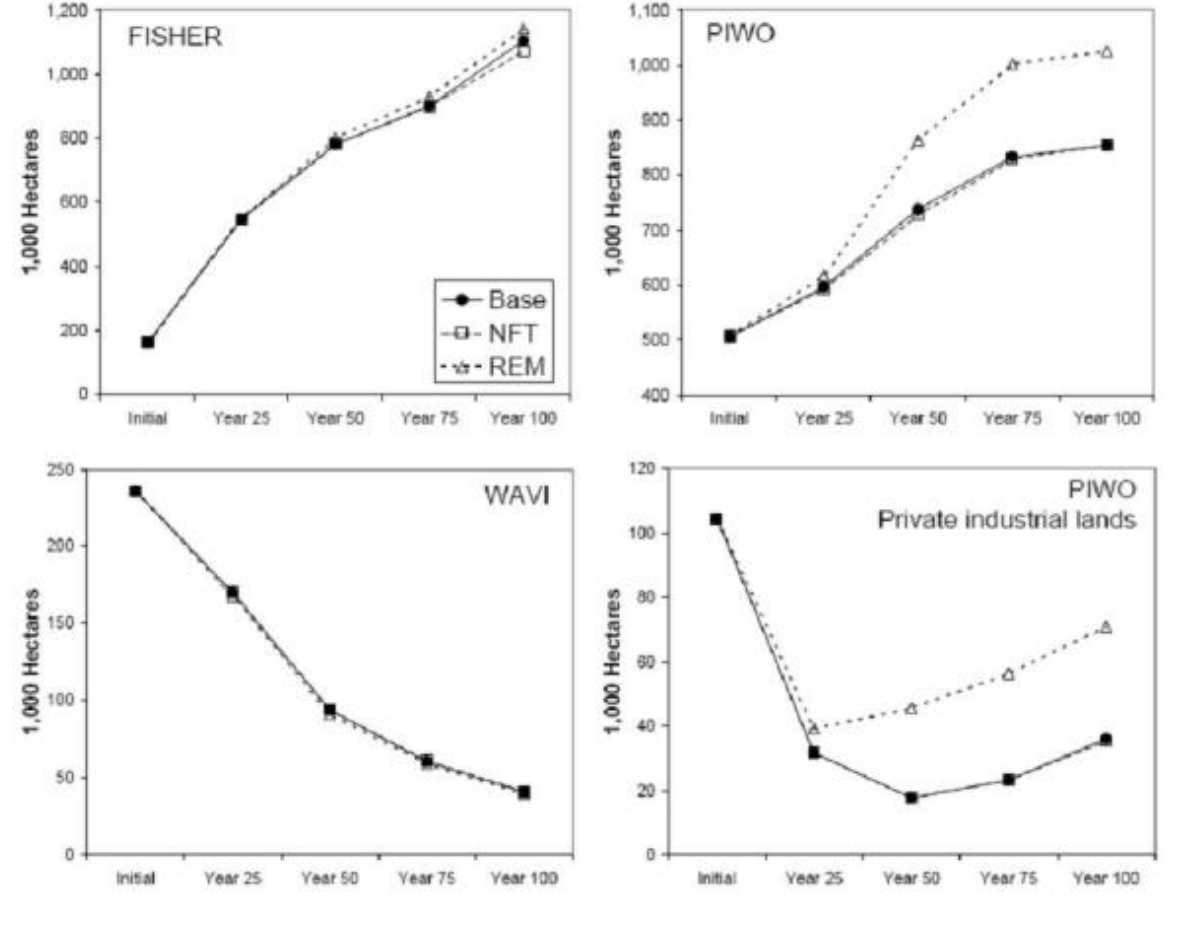
Fig. 3. Estimated changes in habitat availability over a 100-yr simulation in the Oregon Coast Range under current (BASE) and two alternative land management policies on federal, state, and private forest lands for three focal species: Fisher = Pacific Fisher, WAVI = Warbling Vireo, and PIWO = Pileated Woodpecker. Alternative policies are NFT = no forest thinning in young stands on federal lands and REM = increased retention of live and dead trees on private lands. Because trends resulting from the REM policy were so apparent for pileated woodpeckers on private lands, a separate chart is